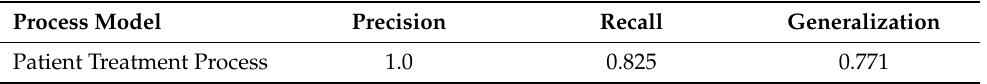
Table 6. Results of the quality metrics for the patient treatment model discovered. Process